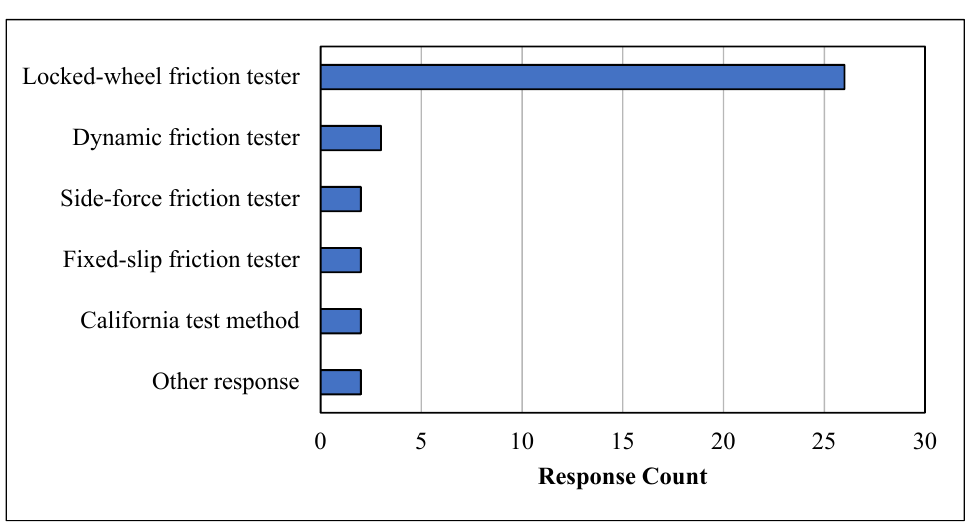
Figure 4. Pavement friction testing methods followed by state DOTs.